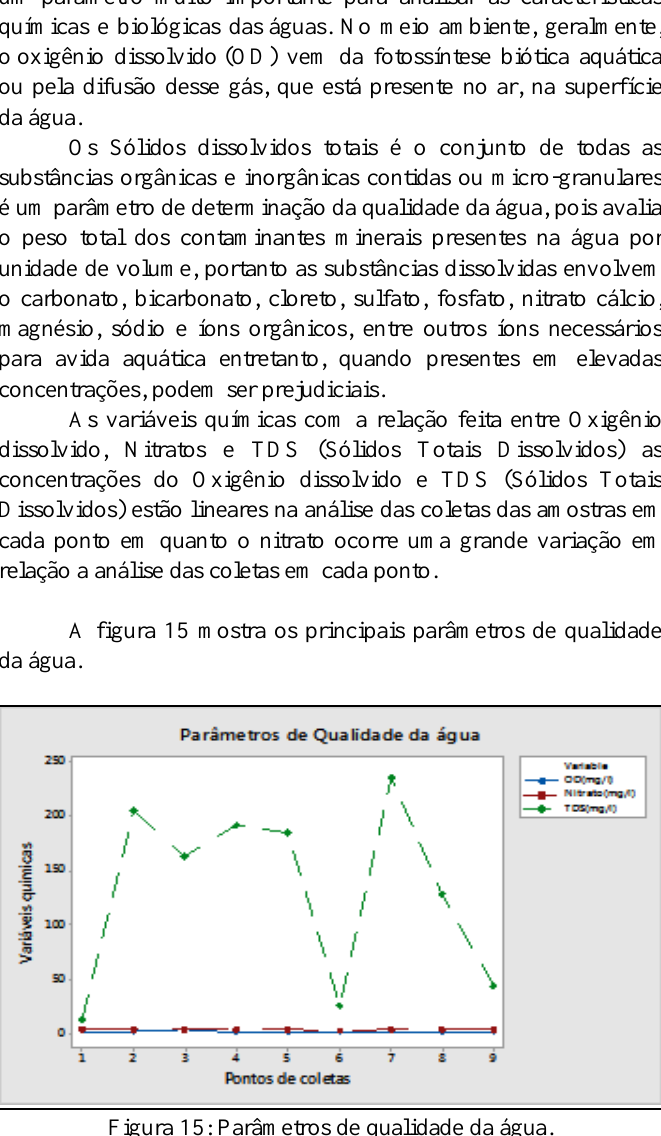
Figura12: Condutividade das amostras. Fonte: Autores, (2018).